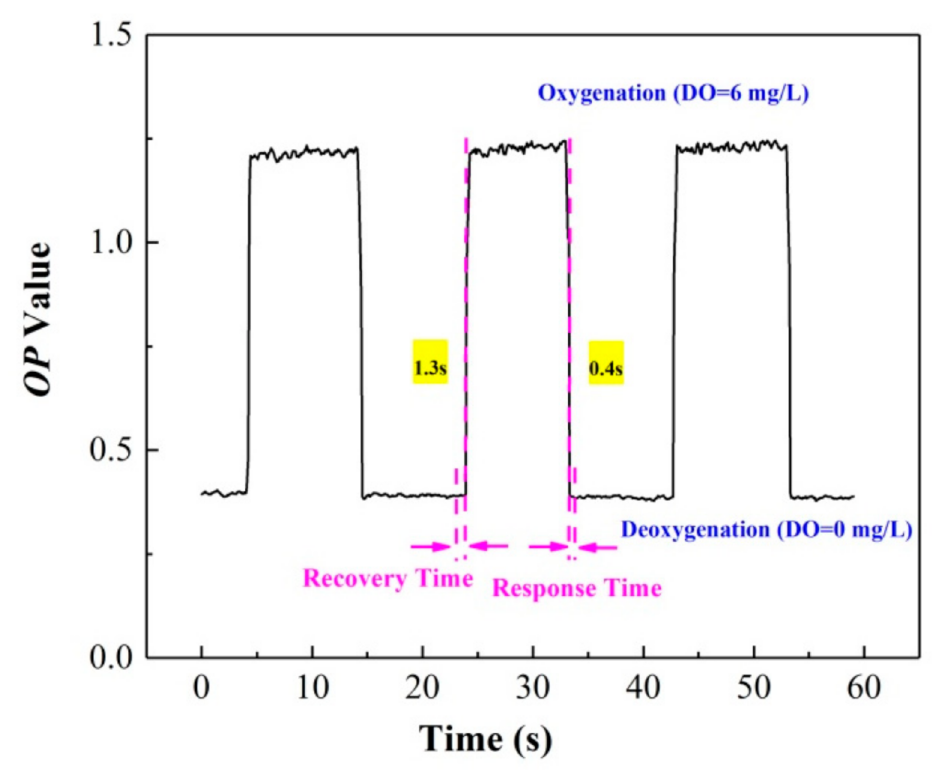
Figure 7. Reversibility and response time of the ratiometric oxygen-sensing system.